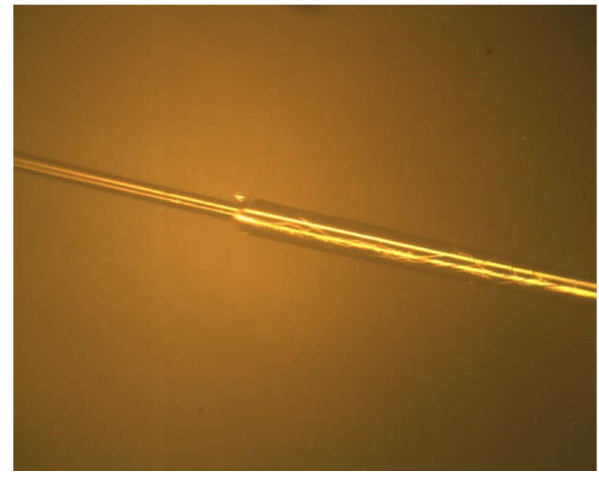
Figure 9. Palladium film coating under the crystal phase microscope.